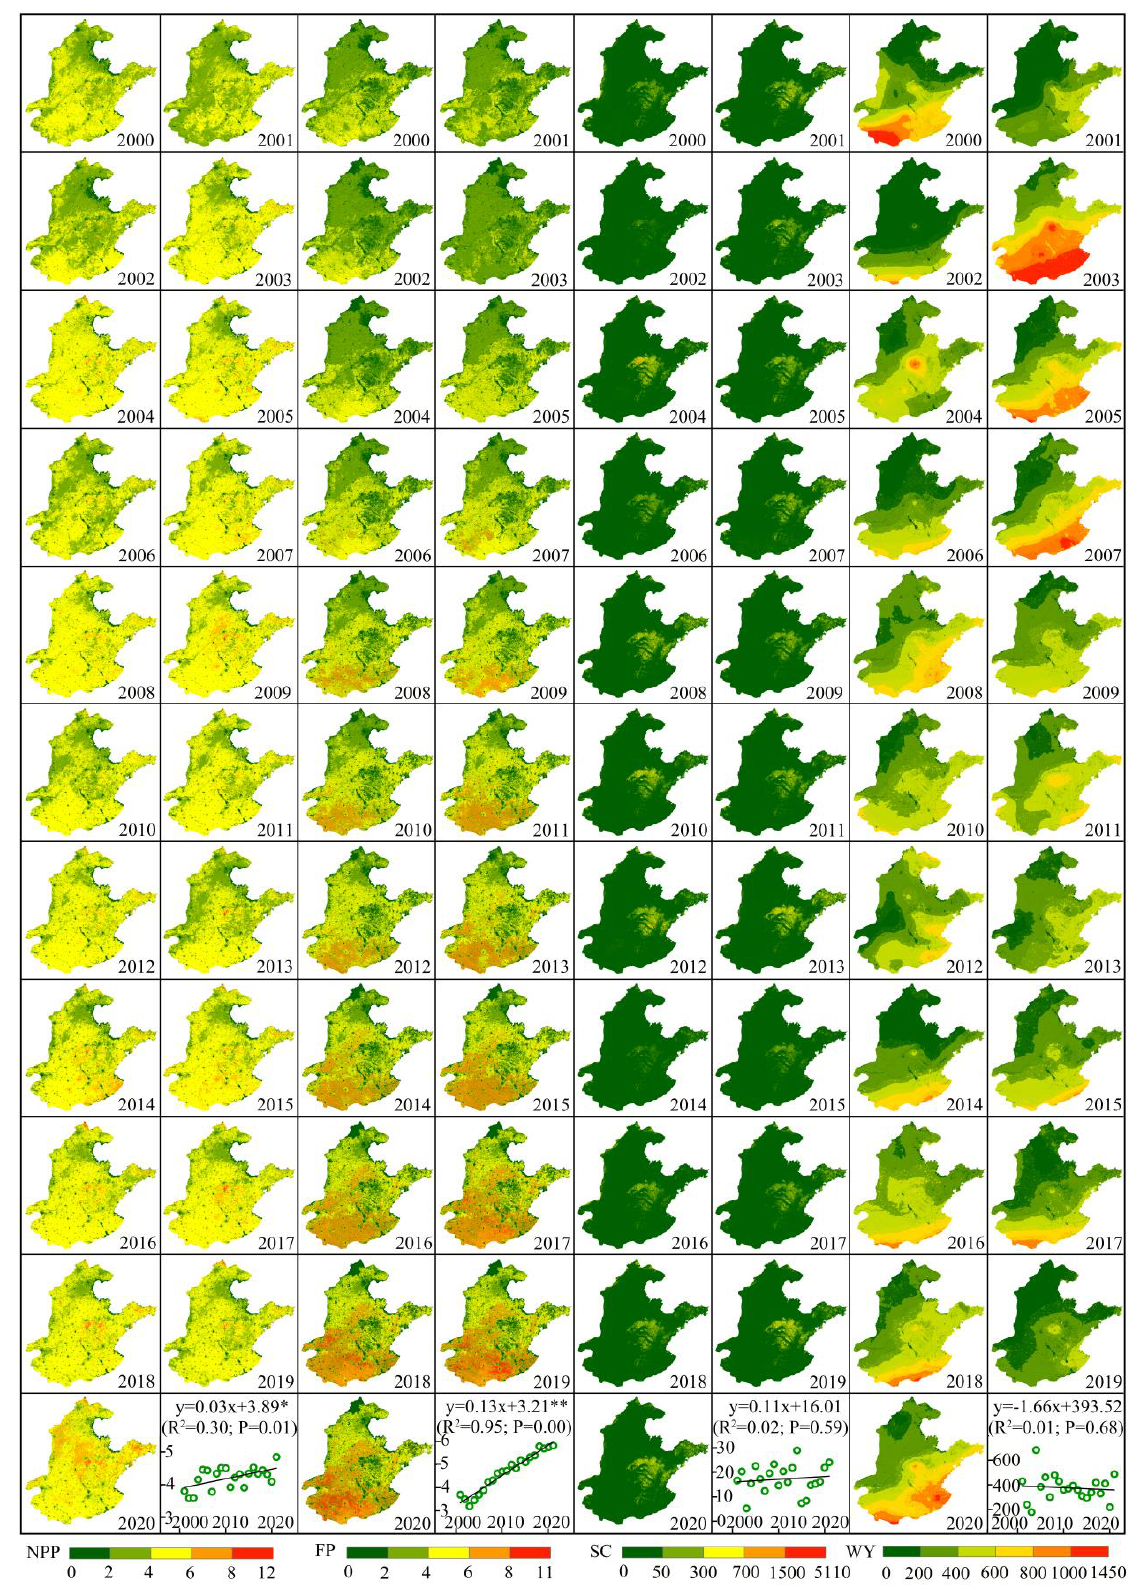
Figure 5. Spatial distribution of ESs from 2000 to 2020. NPP: net primary productivity; FP: food production; SC: soil conservation; WY: water yield. The units of NPP, FP, and SC are t ha − 1 , and the unit of WY is mm. ** means significant at the 0.01 level; * means significant at the 0.05 level.